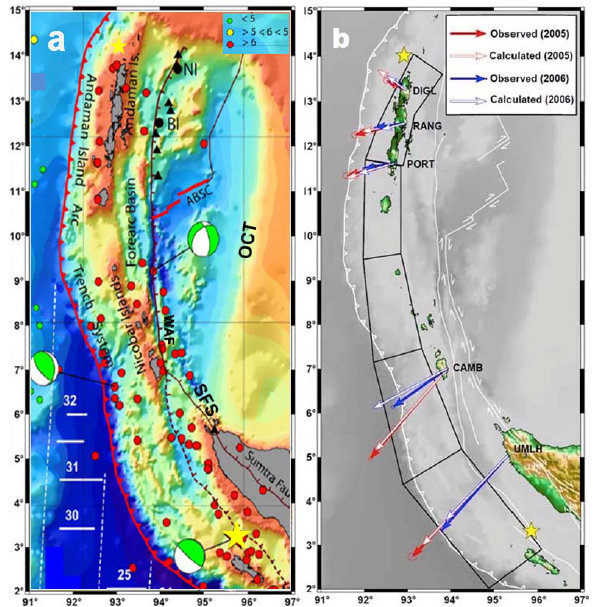
Fig. 1. (a): Tectonic map of the Andaman-Nicobar-Sumatra region superposed on the topography and bathymetry. Andaman arc-trench system, Andaman back arc spreading center (ABSC), Ocean Continental Transition (OCT), West Andaman Fault (WAF) and Sumatra Fault System (SFS) are shown. Black filled circles represent Narcondam (NI) and Barren (BI) island volcanoes. Yellow stars indicate locations of December 26, 2004 Sumatra earthquake (bottom) and that on August 10, 2009 at Diglipur (top). Beachball symbols represent the fault plane solutions for selected events. E-W lines are magnetic lineations and numbers indicate corresponding magnetic anomalies (Subrahmanyam et al., 2008) (b): Comparison of postseismic observed (reckoned from GPS) and calculated surface velocities associated with the 2004 Sumatra-Andaman earthquake. The five areas marked by quadrilaterals along the Andaman-Sumatra subduction zone indicate assumed coseismic fault plane used for modeling postseismic deformation (Reddy et al., 2009).